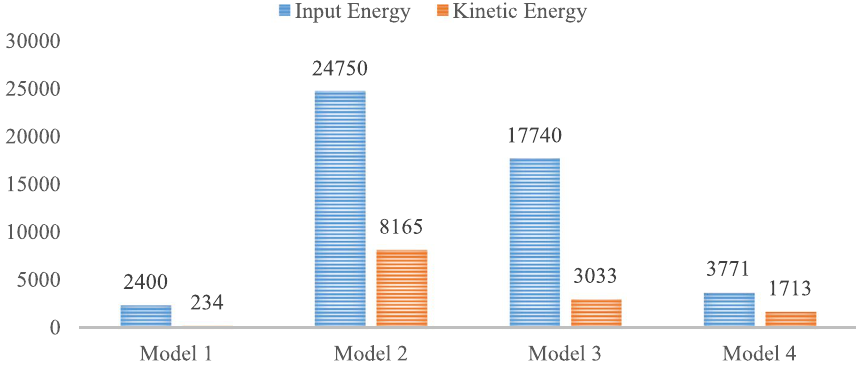
Fig. 21 Input energy and kinetic energy results for the studied models under the Tabas earthquake